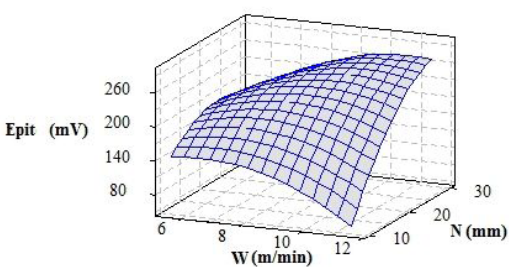
Figure 8. Response surface for interaction effect of wire feed rate ( W ) and nozzle to plate distance ( N ) on pitting potential ( E ( V = 29.5 V; S = 40.0